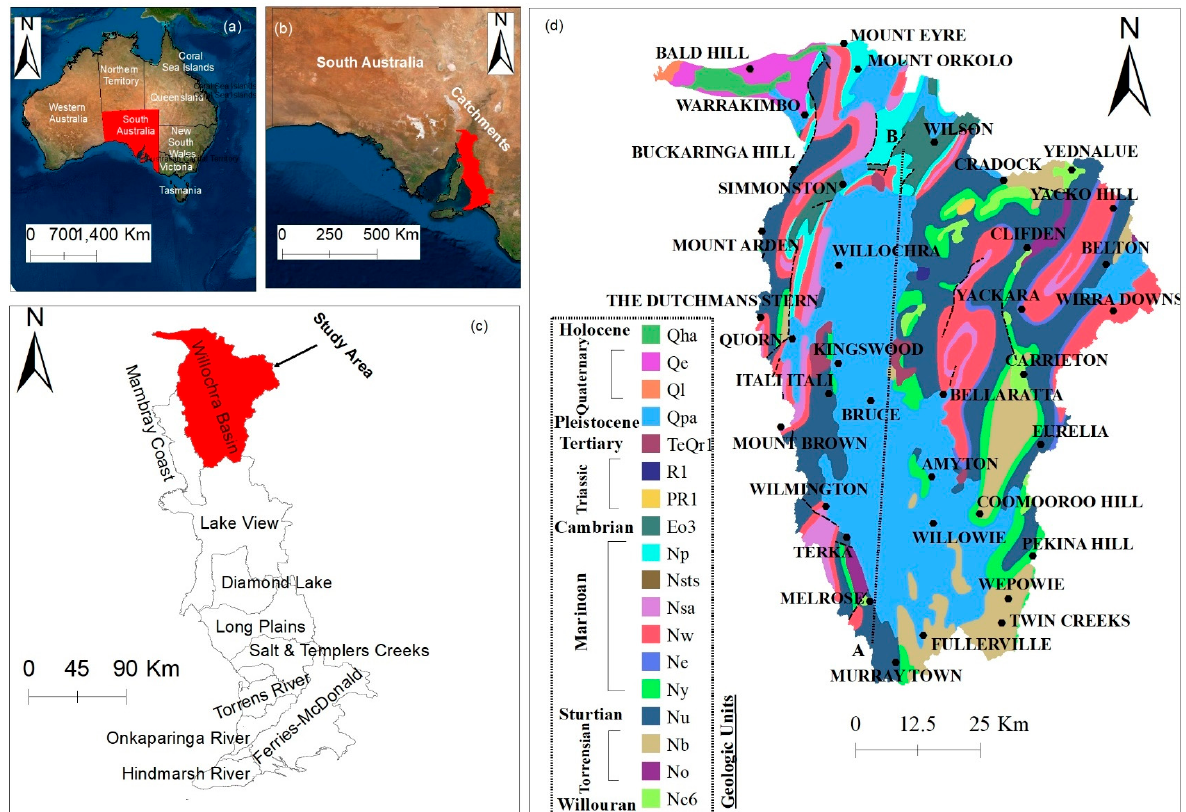
Figure 1. ( a ) Australia, ( b ) South Australia, ( c ) South Australian catchments, ( d ) study area.